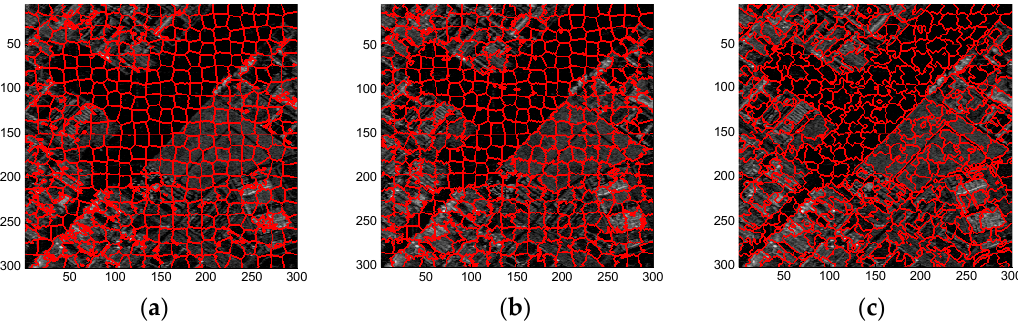
Figure 9. Superpixels of AIRSAR image provided by ( a ) standard SLIC; ( b ) compound method; and ( c ) proposed algorithm with regularization parameter w “ 0.6.